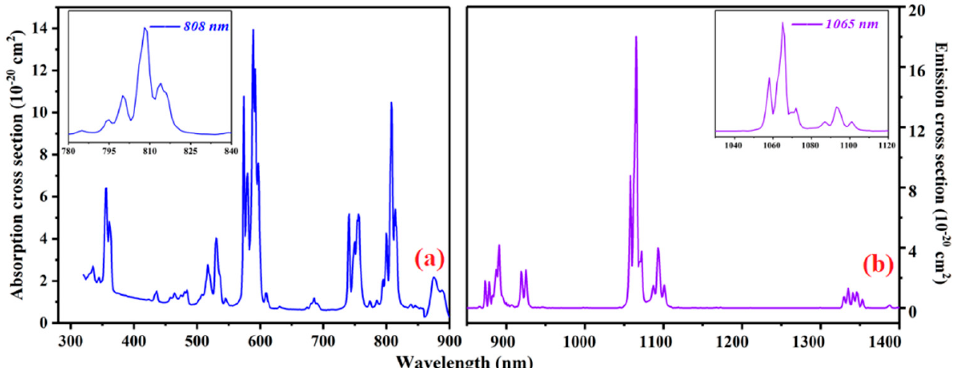
Figure 2. Absorption and fluorescence spectra of the Nd:GLNO crystal. ( a ) Absorption spectra; ( b ) Fluorescence spectra.